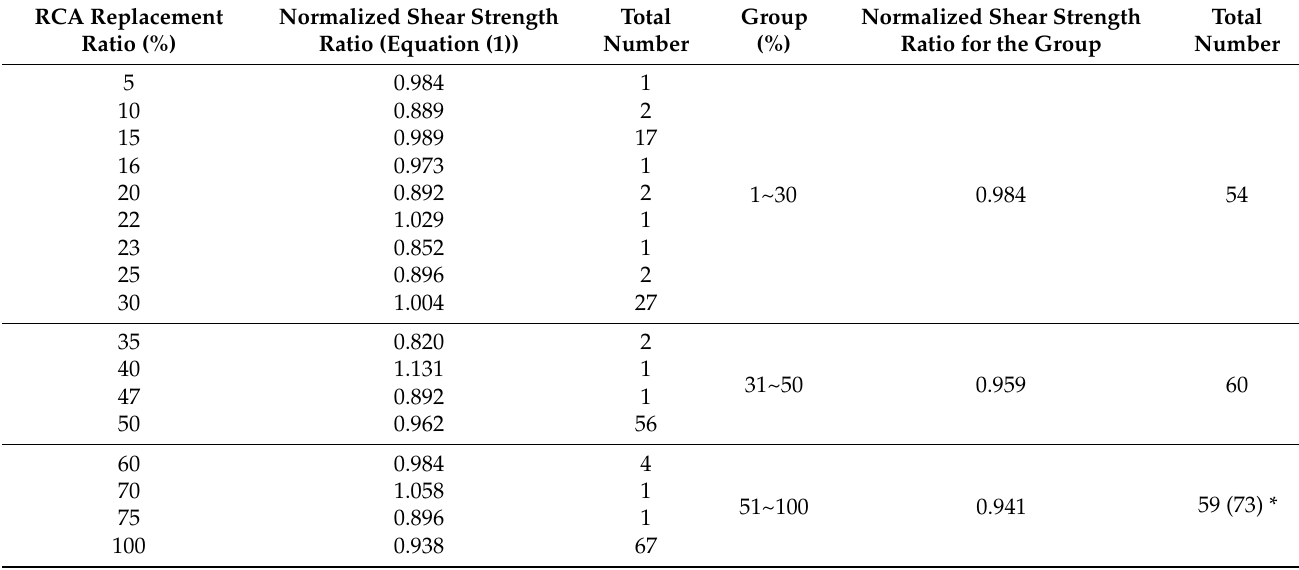
Table 1. Grouping of specimens without shear reinforcement according to RCA replacement ratio.